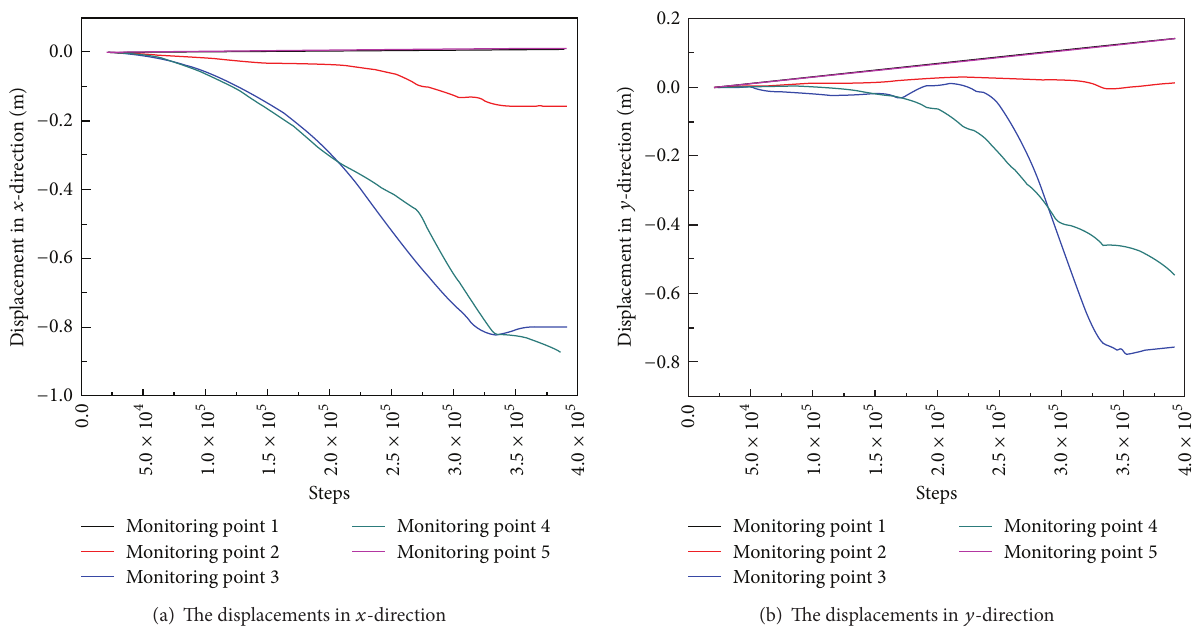
Figure 3: The displacement curves of 5 monitoring points at the right side.